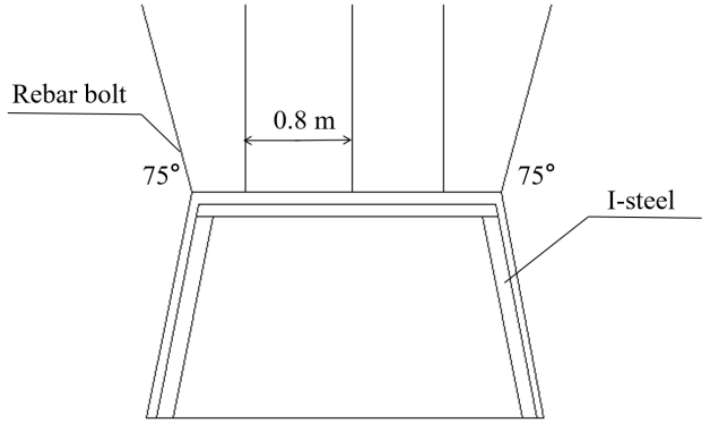
Figure 3. Previous support scheme of return airway of working face 10905.